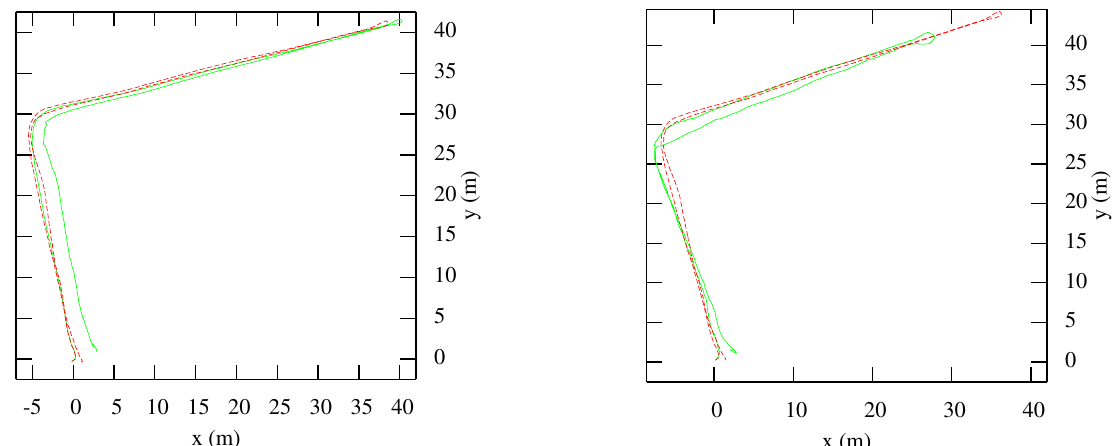
Figure 3. Experimental results for one run with the camera looking forward (left), and a run with the camera looking backwards (right). The reference trajectories recorded by the total station are shown as dashed red lines, the estimated trajectories are shown as green